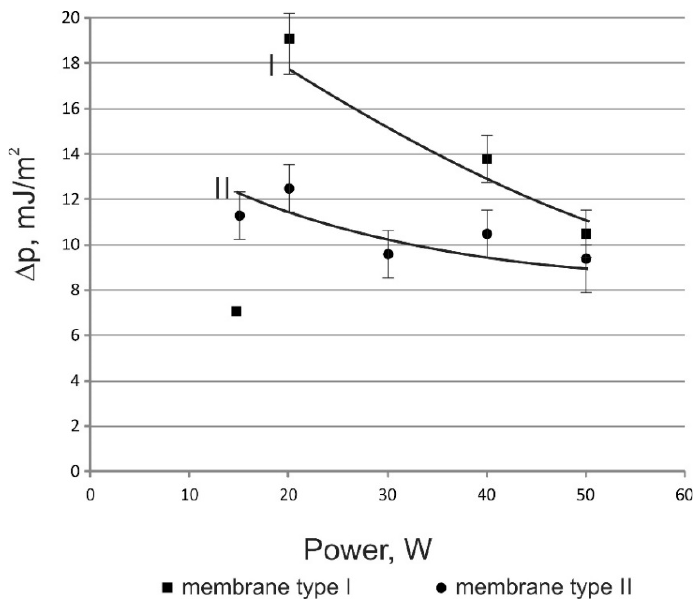
Figure 3. The impact of the barrier discharge power generated in carbon dioxide on the change of the polar component (∆p). The exposure time was 15 s.